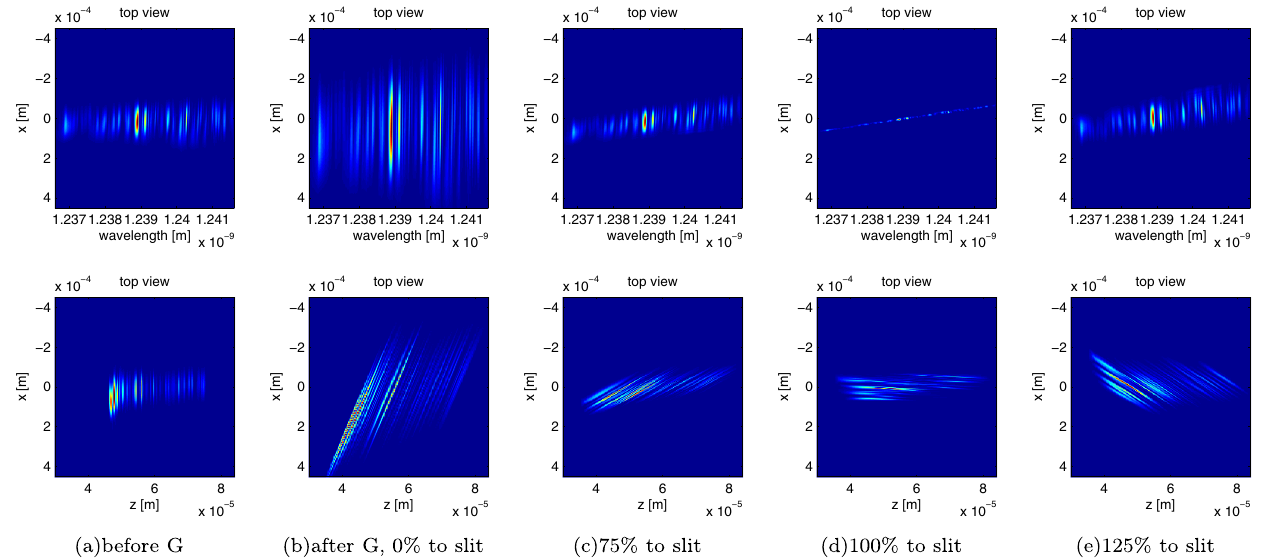
FIG. 19. Frequency (first row) and time (second row) domains of the vertical dispersive projection of 1000 eV radiation pulse propagated after the grating through the slit position.